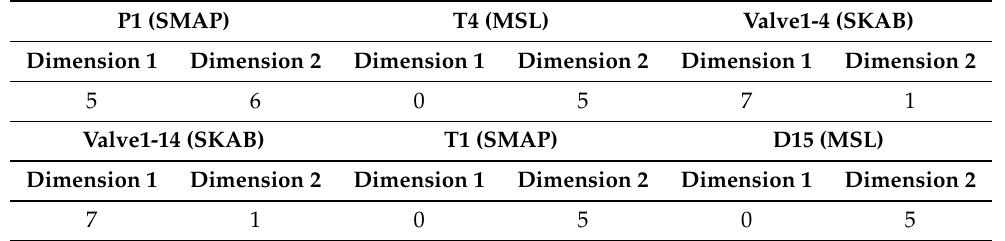
Table 3. Anomaly attribution of CAT-IADEF on different